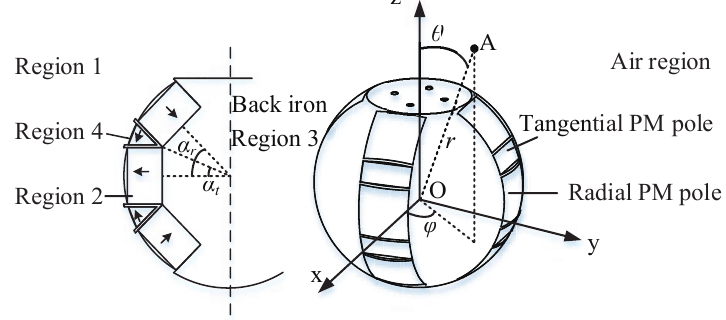
Figure 3. Distribution of PM poles